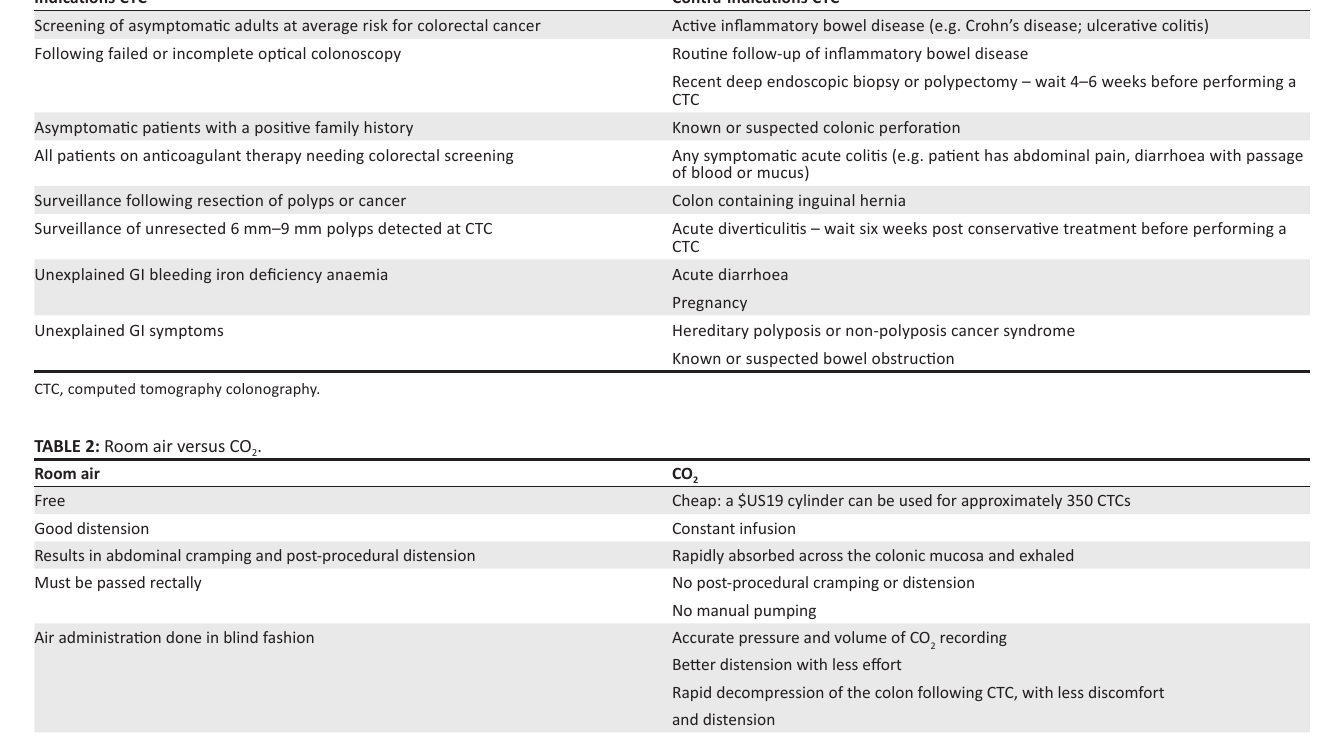
TABLE 1: Indications and contra-indications for CTC. Indications CTC